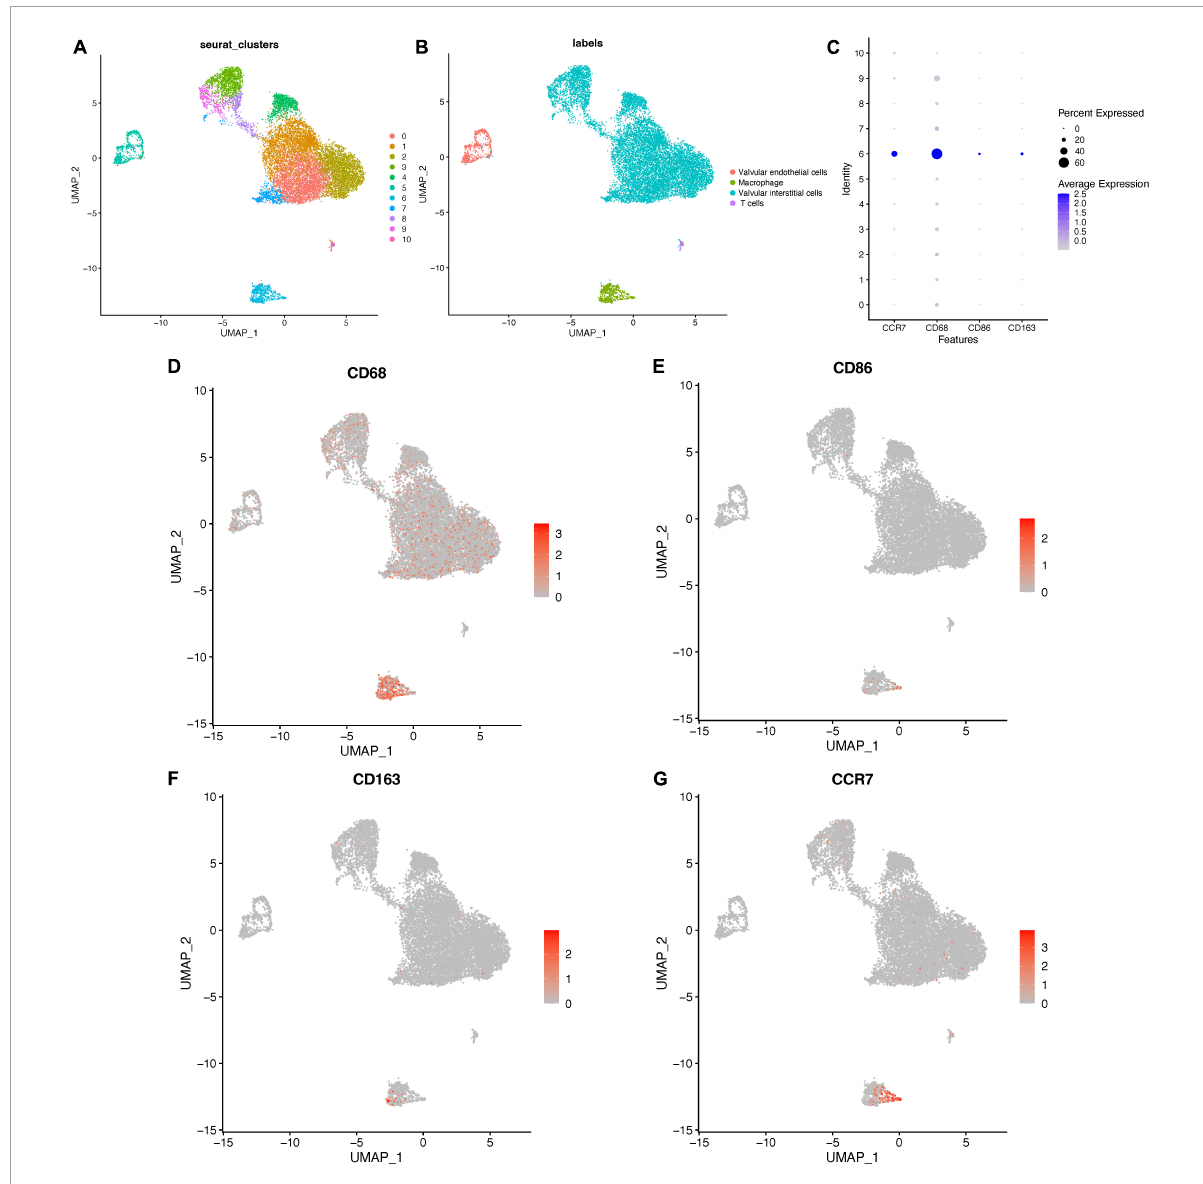
FIGURE8 Distribution of CCR7 in aortic valve cells. (A) The clusters of cells in aortic valve tissues and the annotation of cells (B) in aortic valve tissues. (C) The bubble map of the expressions of different markers in aortic valve cells. (D–G) The distribution of different markers in aortic valve